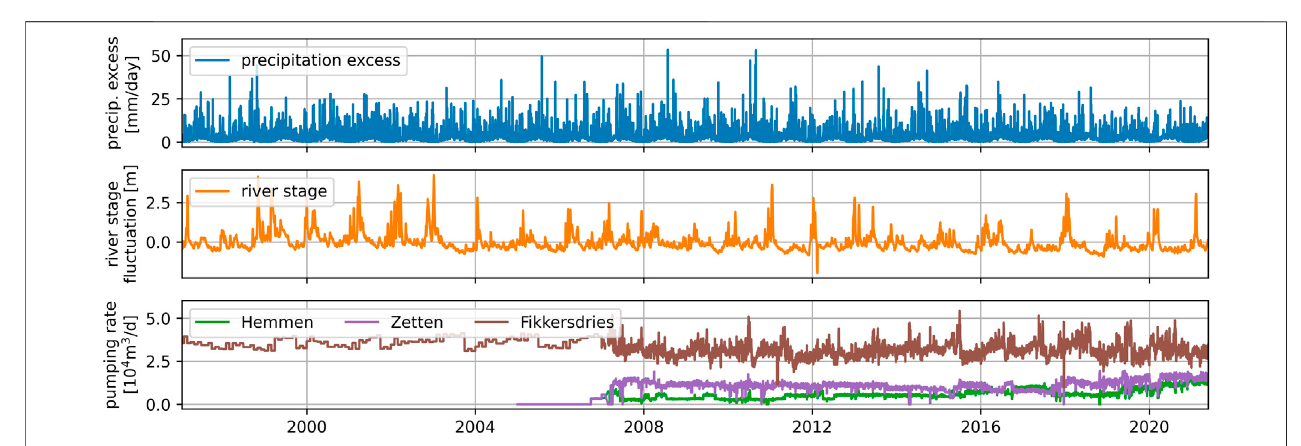
FIGURE 4 | Stresses included in the time series model for observation well B39F0579 (Filter 5).